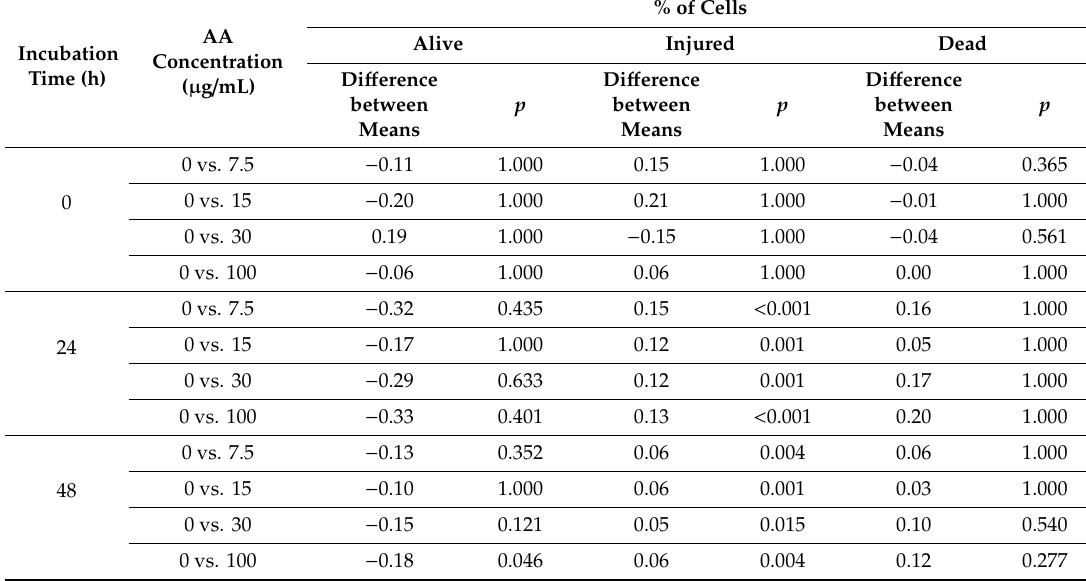
Table 6. The interaction e ff ect of incubation time and concentration of acrylamide on the viability of Lactobacillus brevis (Bonferroni test).